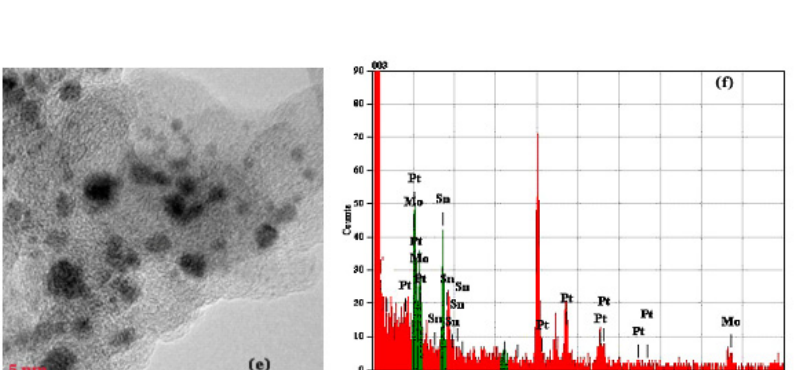
Figure 2. TEM images of the PtMo/C ( a ), PtFe/C ( c ), and PtMoSn/C ( e ) samples; EDX spectra of the PtMo/C ( b ), PtFe/C ( d ), and PtMoSn/C ( f ) samples.